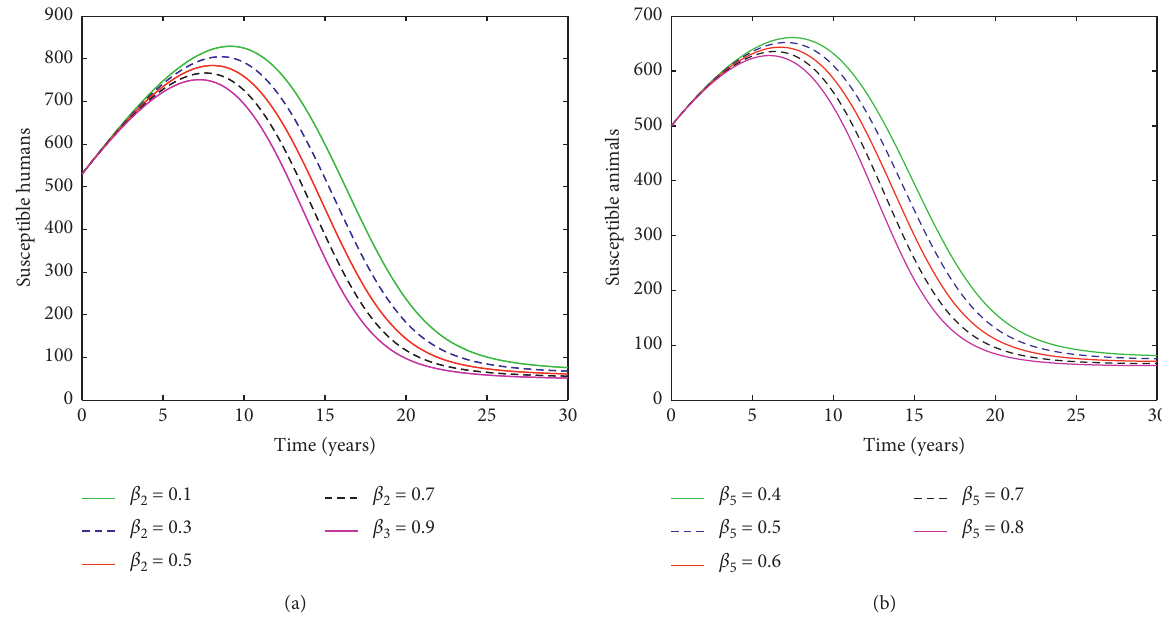
Figure 5: Variation of humans and animals infection rates from infectious animals to susceptible humans and animals classes. (a) Susceptible humans. (b) Susceptible animals.